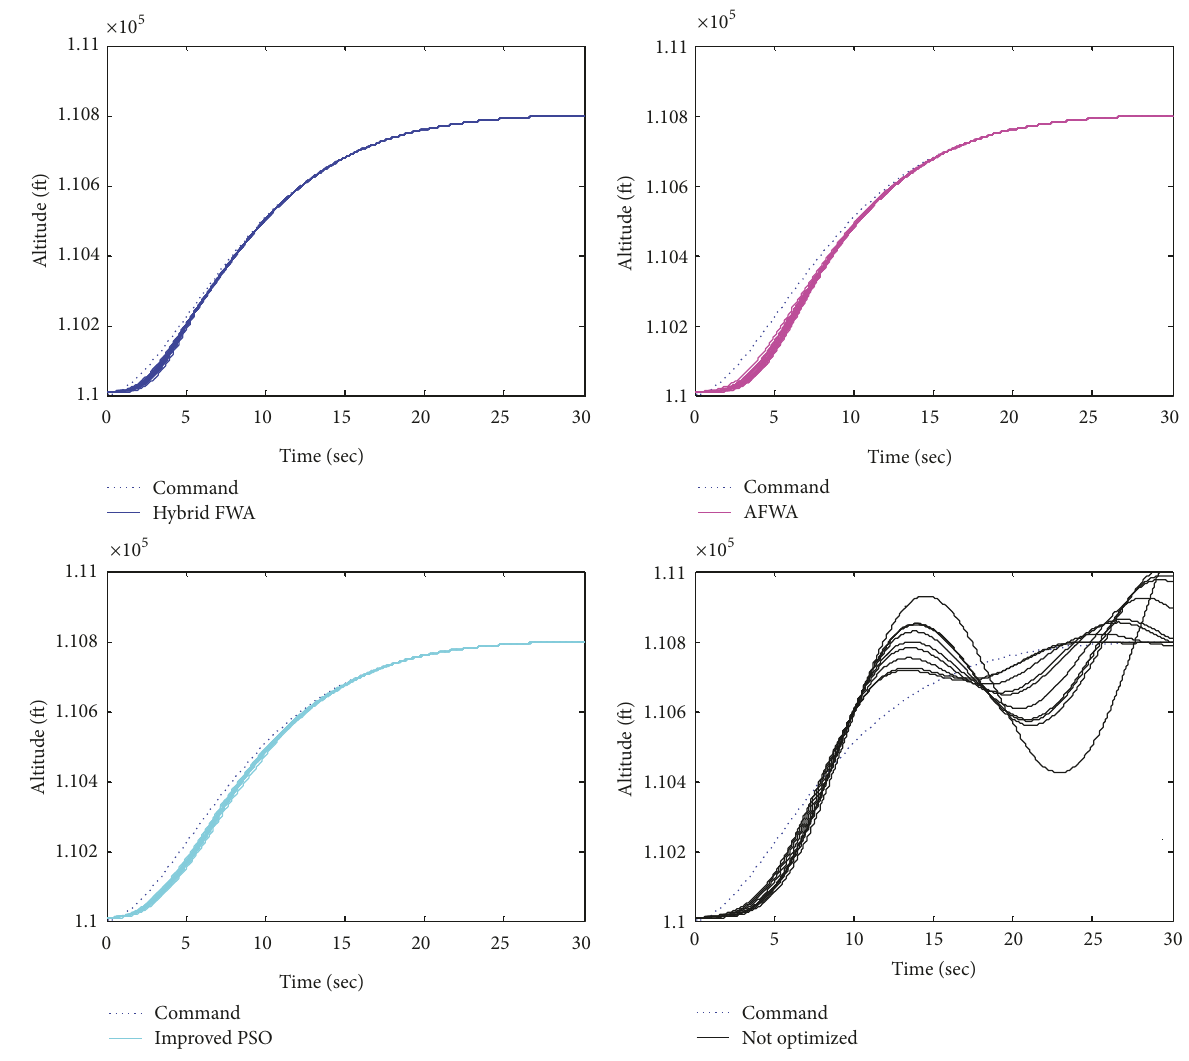
Figure 11: Random responses using various controller